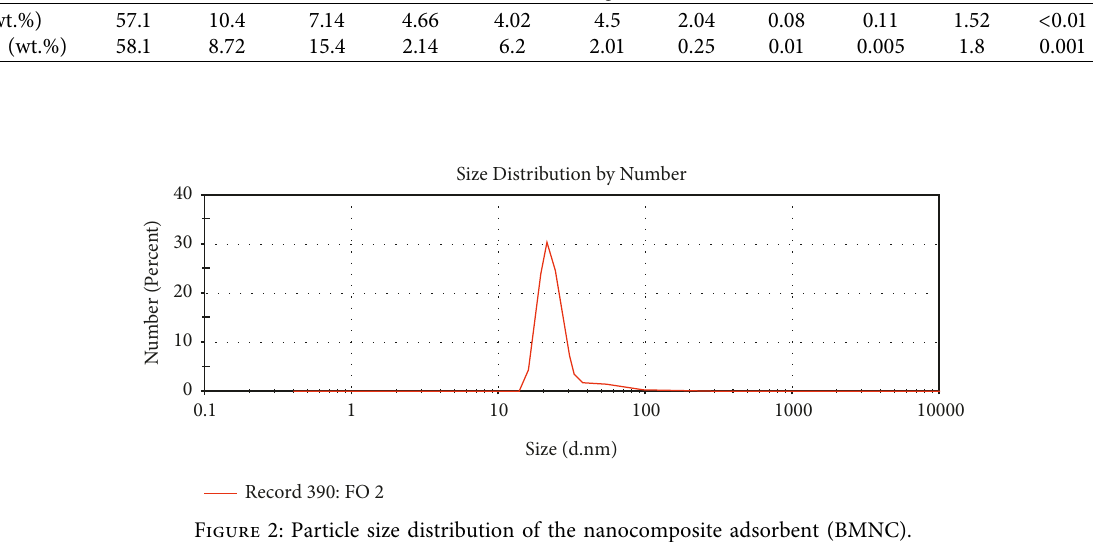
Table 3: Chemical composition of bentonite (BNa) and the nanocomposite adsorbent (BMNC) using AAS. Parameters